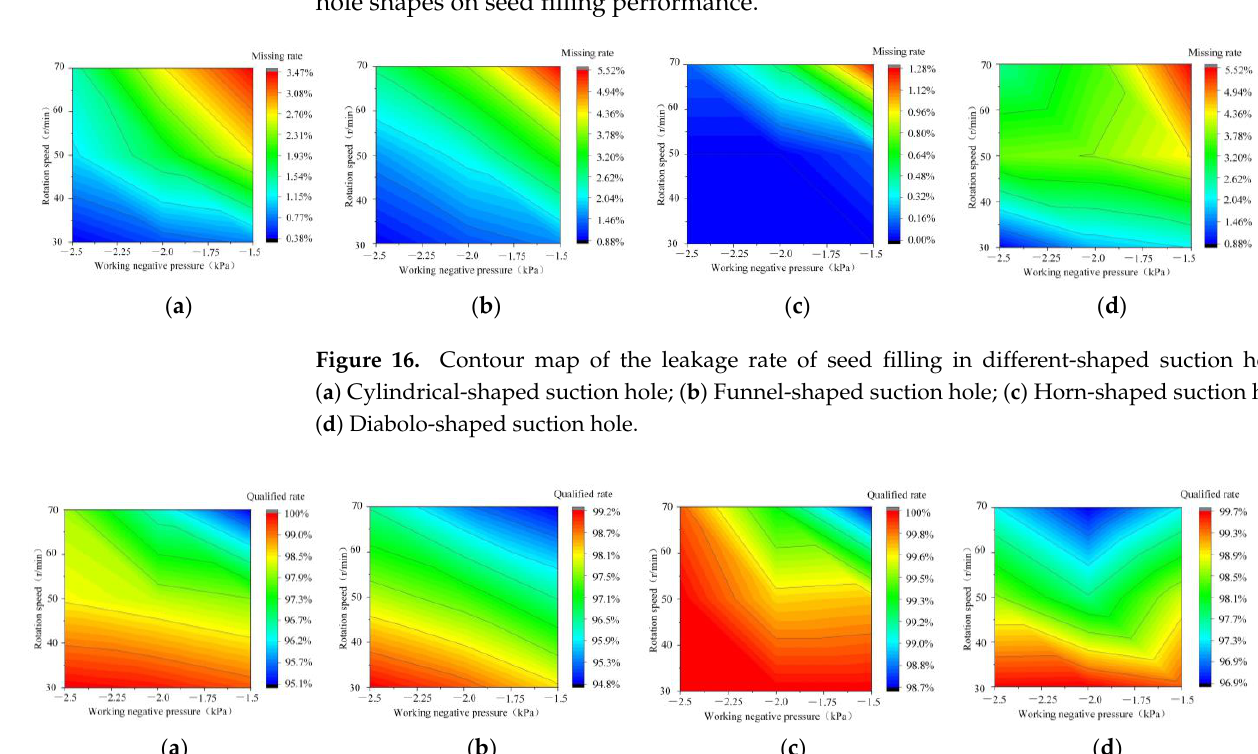
Figure 17. Contour map of the quality rate of seed filling in different-shaped suction holes. ( a ) Cylindrical-shaped suction hole; ( b ) Funnel-shaped suction hole; ( c ) Horn-shaped suction hole; ( d ) Diabolo-shaped suction hole.